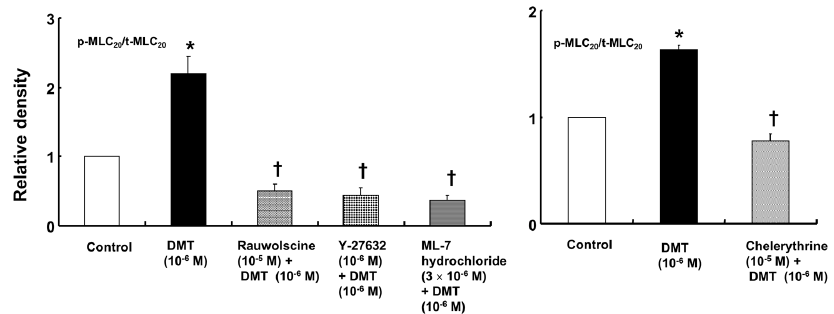
Figure 6. Effect of rauwolscine ( n = 4), Y-27632 ( n = 4), ML-7 hydrochloride ( n = 4), and chelerythrine ( n = 4) on the phosphorylation of 20-kDa regulatory light chain of myosin (MLC 20 ) at Ser19 induced by dexmedetomidine (DMT, 10 − 6 M) in rat aortic vascular smooth muscle cells (VSMCs). VSMCs were treated with 10 − 6 M DMT alone for 6 min or 10 − 6 M DMT for 6 min after pretreatment with 10 − 5 M rauwolscine, 10 − 6 M Y-27632, 3 × 10 − 6 M ML-7 hydrochloride, or 10 − 5 M chelerythrine for 1 h. The data are presented as the mean ± SD. N indicates the number of independent experiments. The effects of rauwolscine, Y-27632, ML-7 hydrochloride, and chelerythrine on the phosphorylation of MLC 20 at Ser19 induced by DMT were analyzed using one-way analysis of variance followed by Bonferroni’s post hoc test. * p < 0.001 versus control. † p < 0.001 versus 10 -6 M DMT alone. p-MLC 20 : phosphorylated MLC 20 , t-MLC 20 : total MLC 20 .